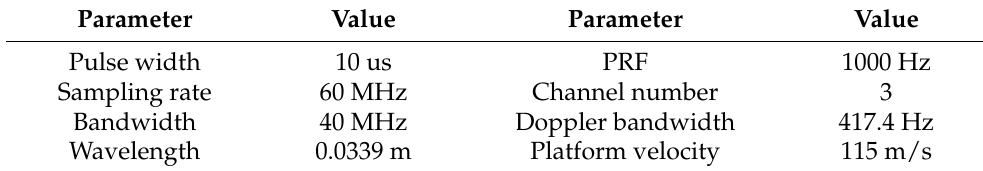
Table 4. Parameters of real measured SAR